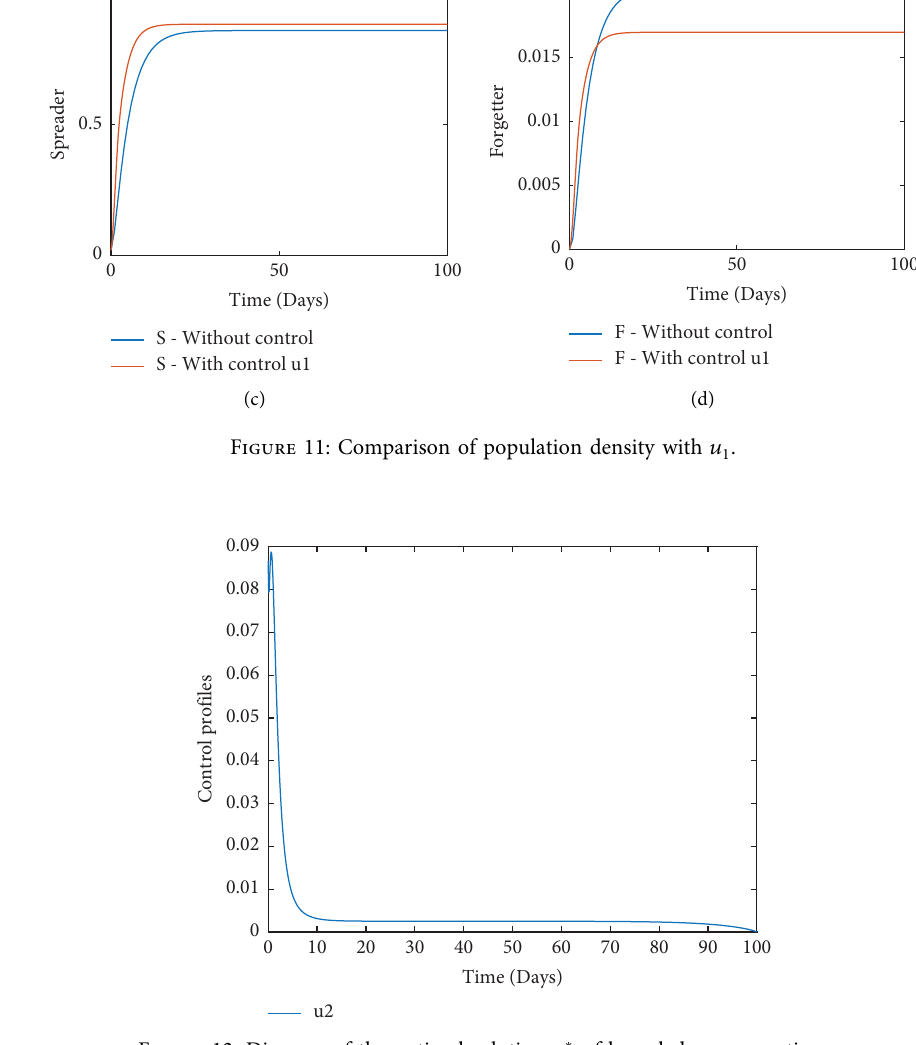
of knowledge propagation. 2